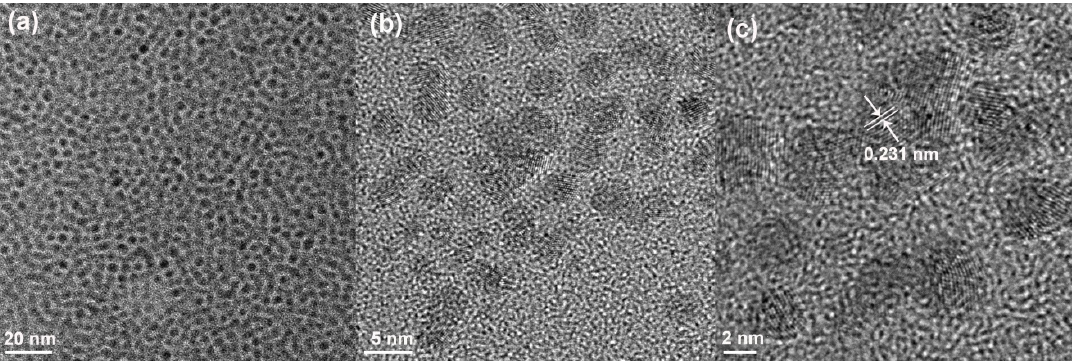
Figure 1. Low-resolution image of palladium nanoparticles (Pd NPs) ( a ), and lattice fringes of Pd NPs at high resolutions ( b , c ).